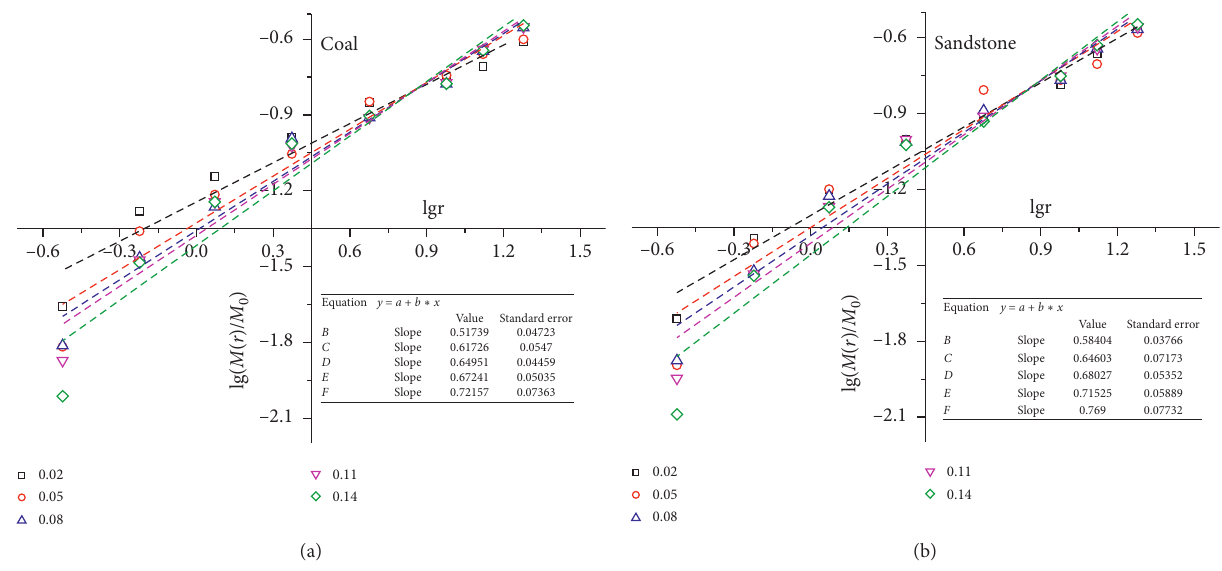
Figure 11: Logarithmic curves under different unloading rates. (a) Coal. (b) Sandstone. Table 8: Fractal dimension of fragmentation under different initial unloading confining pressures.